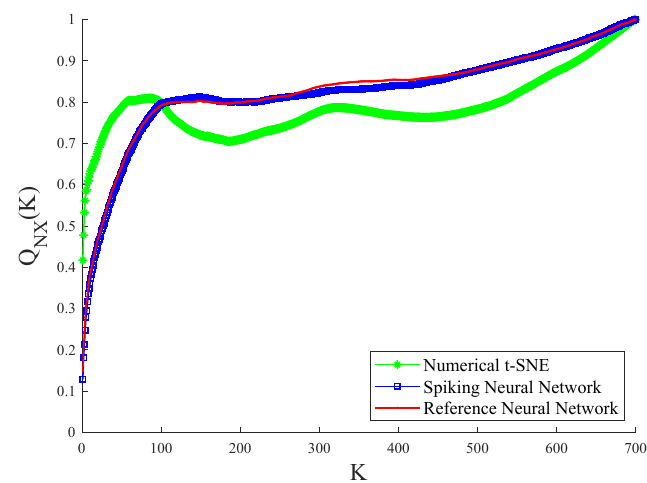
Figure 16. The graphs of the co-ranking